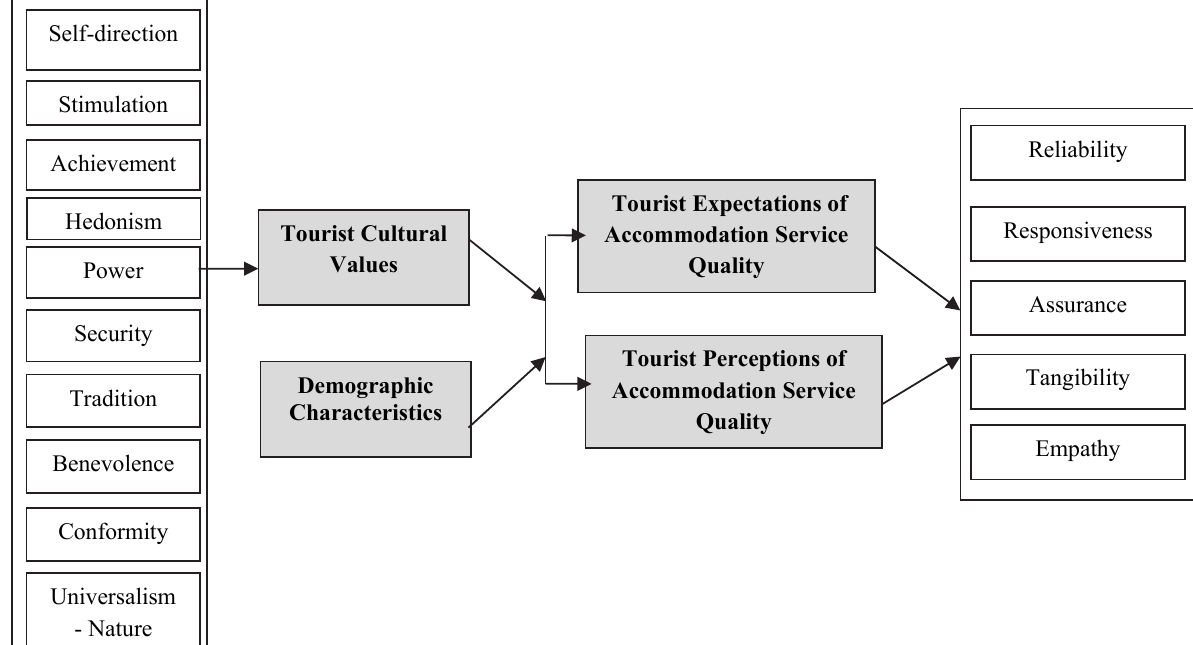
Fig. 1. Conceptual Model of Cultural Values, Service Quality Expectations and